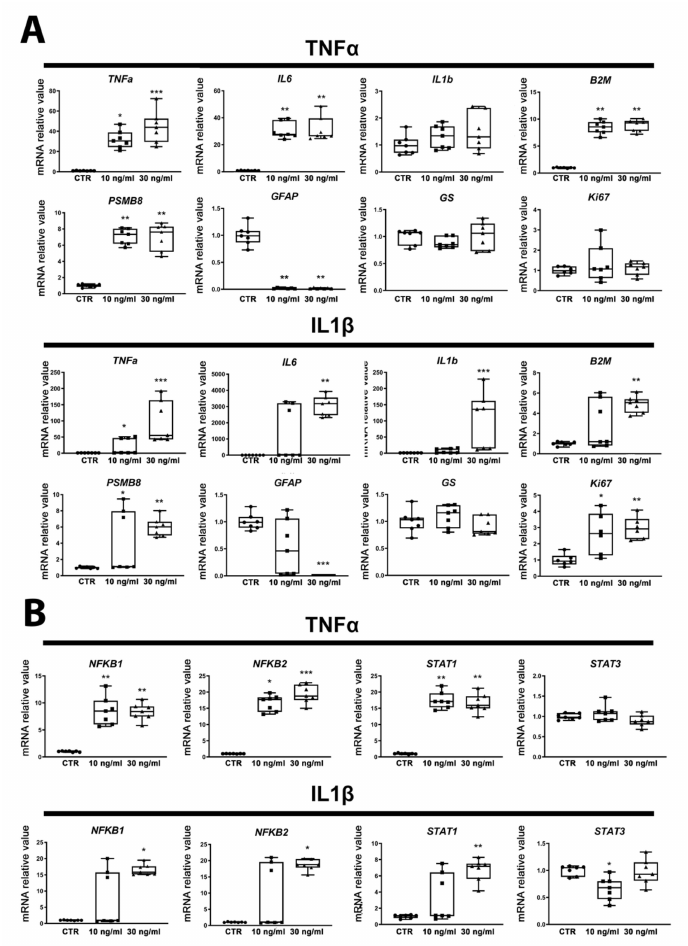
Figure 2. Exposure to cytokines induces human ReN-derived astrocyte reactivity. ( A ) Relative mRNA levels of genes involved in astrocyte reactivity after 24 h of exposure to TNF α or to IL1 β . ( B ) Gene expression regulation of transcription factors after 24 h of exposure to TNF α or to IL1 β . Results are displayed as boxplots with data points, for each group n = 7 samples obtained in 2 independent experiments. The line in the box indicates the median, whereas top and bottom of the box represent the 75th and 25th percentiles; whiskers extend from minimum to maximum values. Statistical analysis was performed by using Kruskal–Wallis test followed by Dunn’s multiple comparisons test. * p < 0.05; ** p < 0.01; *** p <